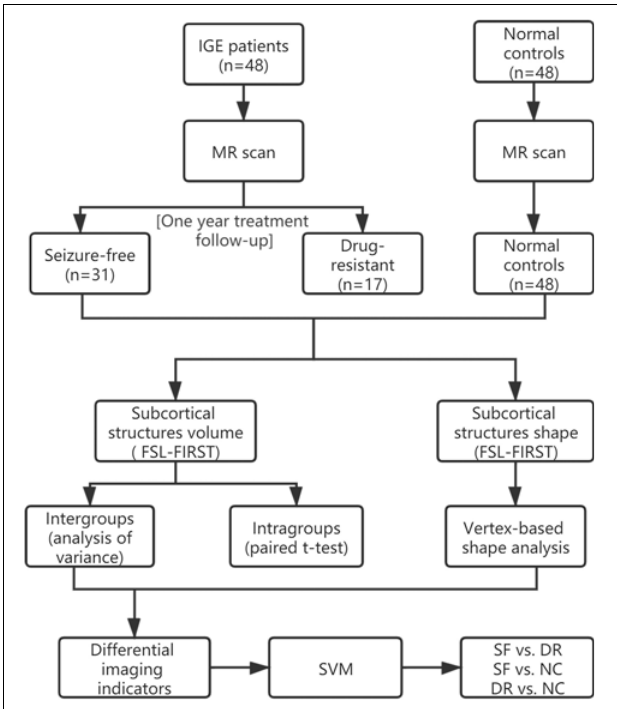
FIGURE 1 | Schematic figure of the analytical methods.